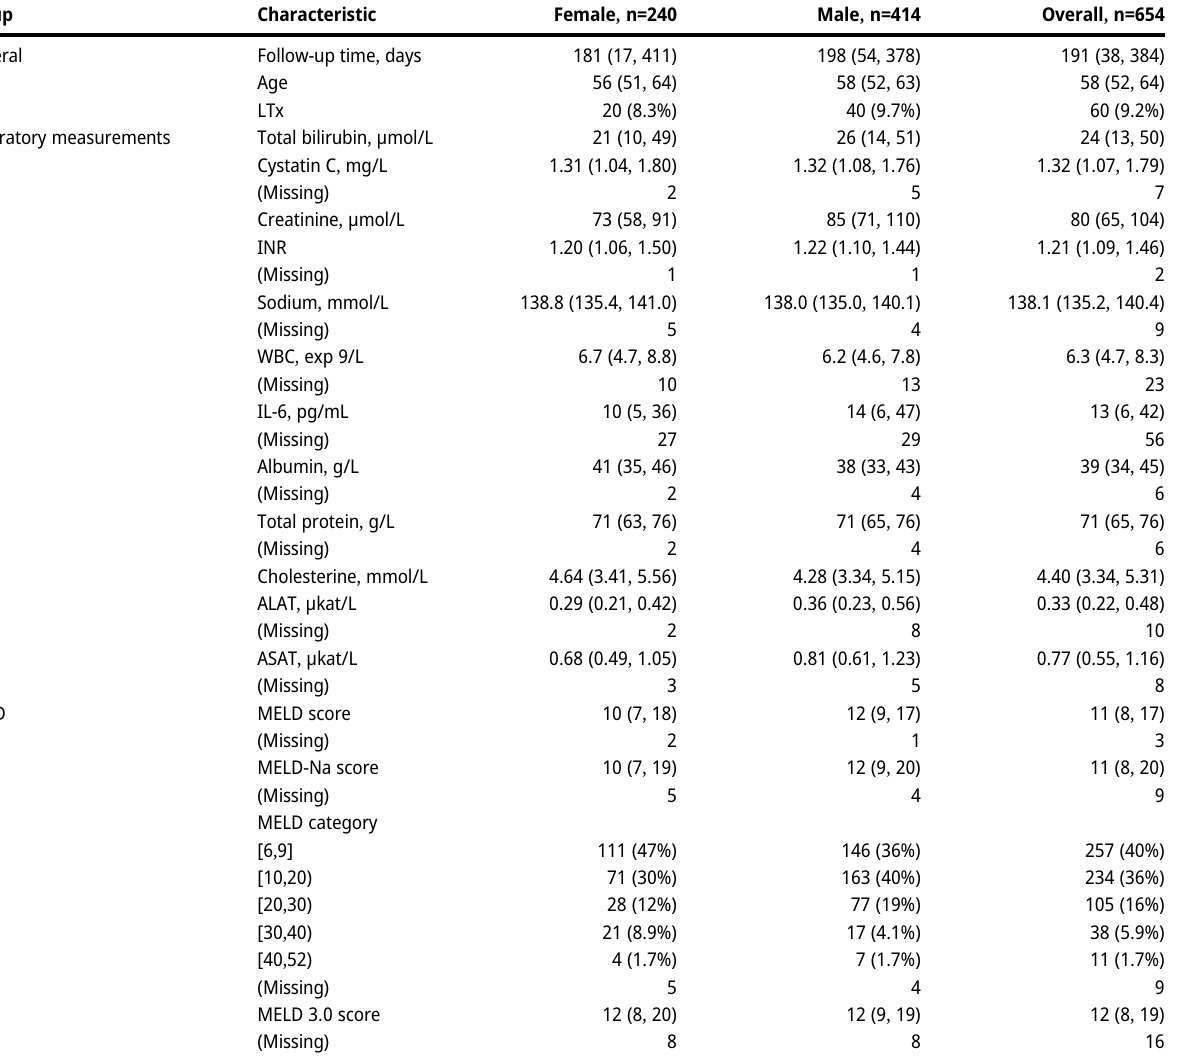
Table  : Baseline characteristics.